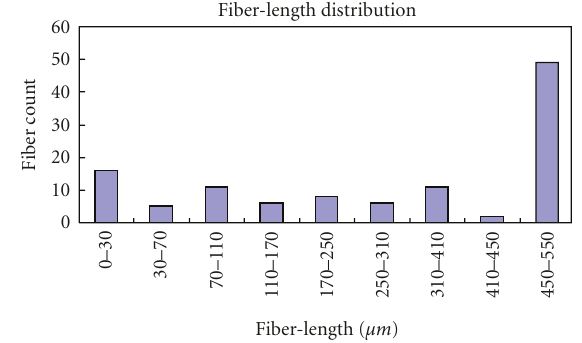
Figure 12: Resulting fiber-length distribution of dataset one. As expected from the visual inspection, the majority of the detected fibers are rather